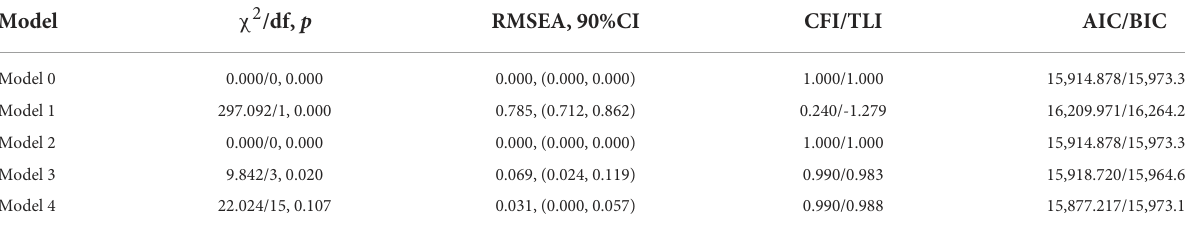
TABLE 3 Fit indexes of the